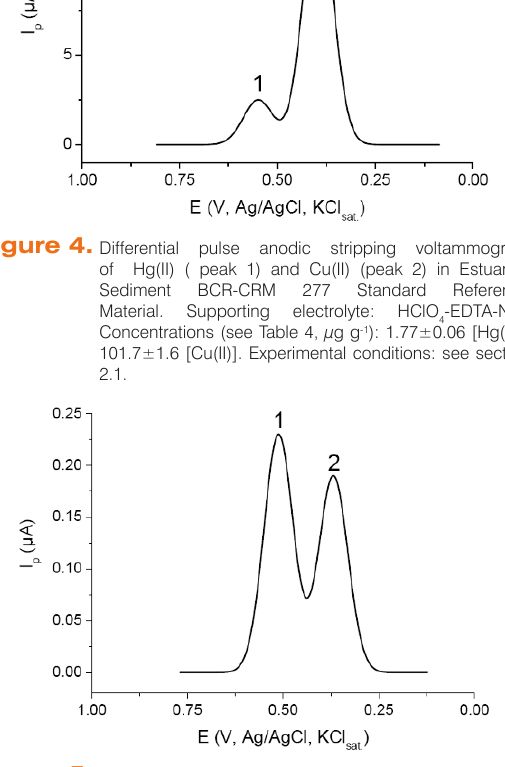
Figure 5. Differential pulse anodic stripping voltammogram of Hg(II) ( peak 1) and Cu(II) (peak 2) in Mercury in Water NIST-SRM 1641d Standard Reference Material. Supporting electrolyte: HClO -EDTA-Na . 4 2